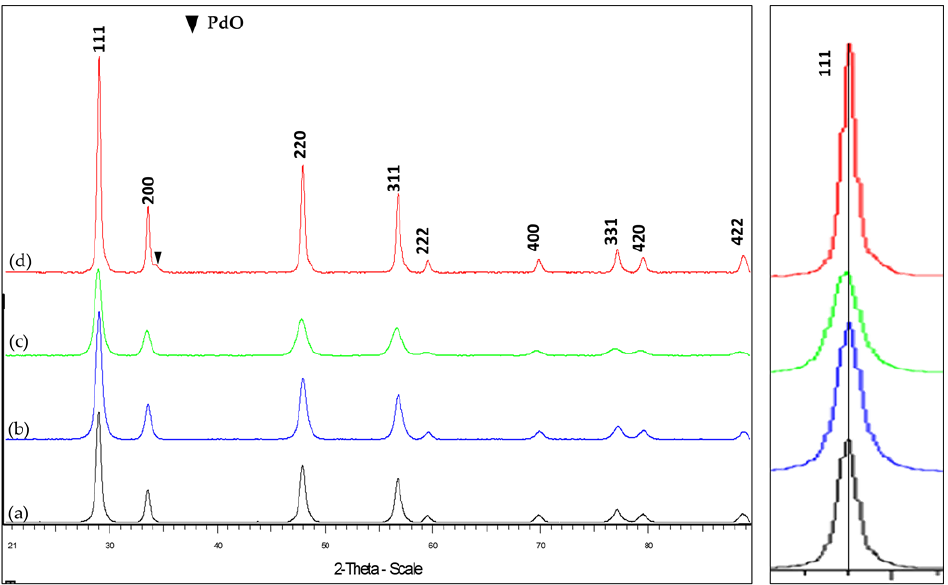
Figure 3. X-ray diffractograms of ( a ) CeO 2 , ( b ) Ce 0.97 Zr 0.03 O 2-δ , ( c ) Ce 0.87 Zr 0.03 Pd 0.08 O 2-δ and ( d ) Figure 3. X-ray di ff ractograms of ( a ) CeO 2 , ( b ) Ce 0.97 Zr 0.03 O 2- δ , ( c ) Ce 0.87 Zr 0.03 Pd 0.08 O 2- δ and Pd/Ce 0.97 Zr 0.03 O 2-δ with the magnified region at 29° 2-theta . ( d ) Pd / Ce 0.97 Zr 0.03 O 2- δ with the magnified region at 29 ◦ 2-theta. Table 3. d-spacing and strain calculations of the respective materials .